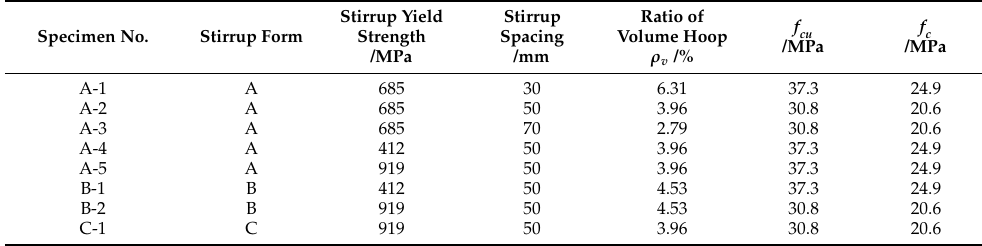
Figure 1. Specimen size and stirrup form. ( a ) four-spiral composite stirrups; ( b ) five-spiral composite stirrups; ( c ) traditional well-shaped composite stirrups; ( d ) 3d diagram of four-spiral composite stirrups; ( e ) 3d diagram of traditional well-shaped composite stirrups; ( f ) A geometric model of confined concrete column. Table 1. Design parameters of specimen.